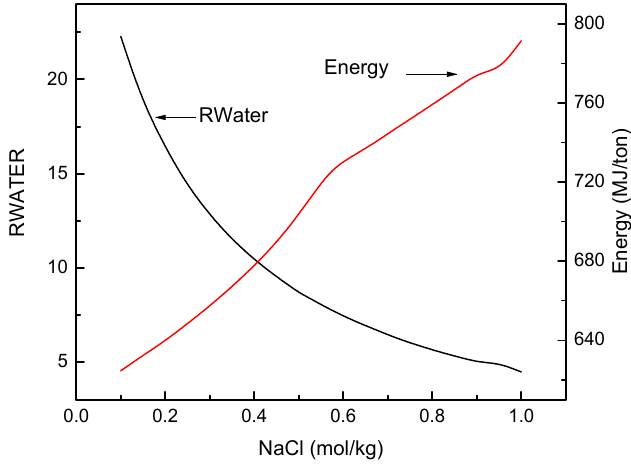
Figure 4. The effect of feed solution concentration on the FO process performance using NH 3 -CO 2 as the draw solute.